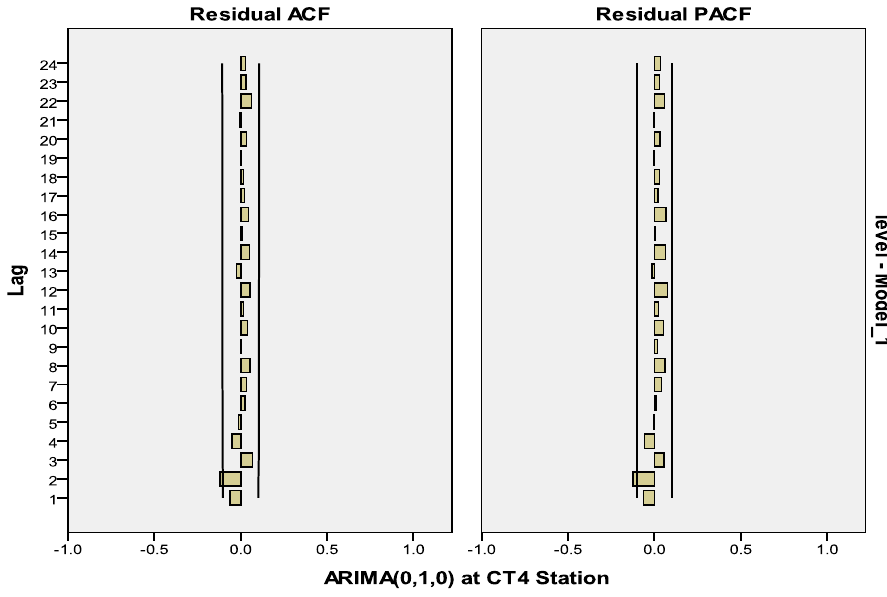
Figure 10. Correlogram of ACF and PACF in the ARIMA(0,1,0) analysis of CT4 station. Table 5. Possible model of each station.